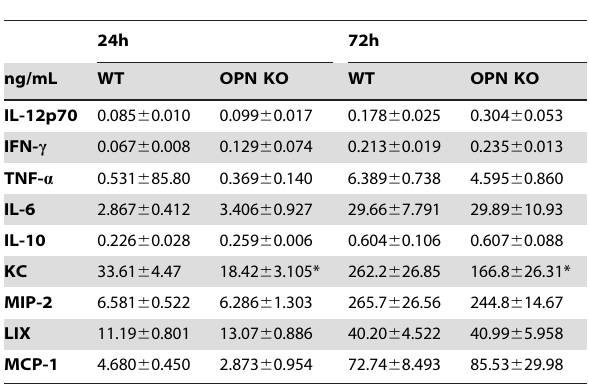
Proinflammatory cytokine (IL-12p70, IFN- c , TNF- a and IL-6), anti-inflammatory IL-10 and chemokine (MIP-2, KC, LIX and MCP-1) levels in lung at 24 and 72 h after intranasaal B. pseudomallei infection in WT and OPN KO mice. Data are expressed as means 6 SEM; n=8 mice/group/time point. * P , 0.05 vs. WT at the same time point. KC ( P =0.05) upon incubation with B. pseudomallei in vitro (data not shown).